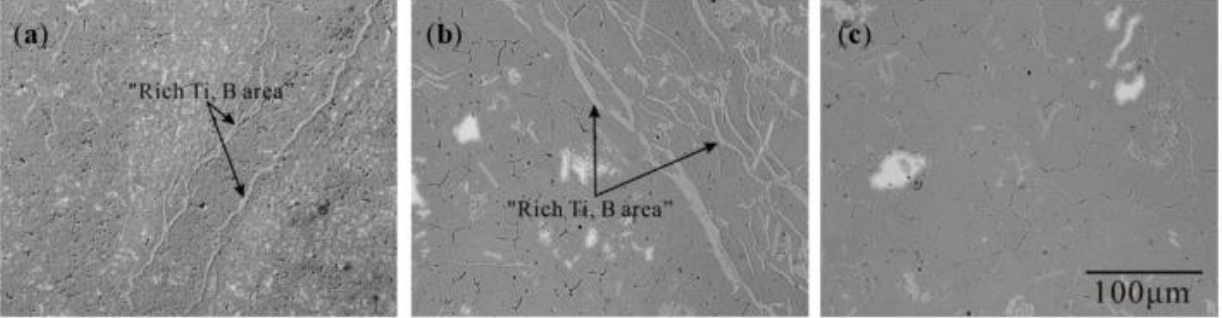
Figure 10. The “rich Ti, B area” in different Al–Ti–B Master Alloy prepared routes at 800 ◦ C for 15 S: ( a ) halide salt route; ( b ) 60% Ti-sponge route; ( c ) Ti-sponge route.